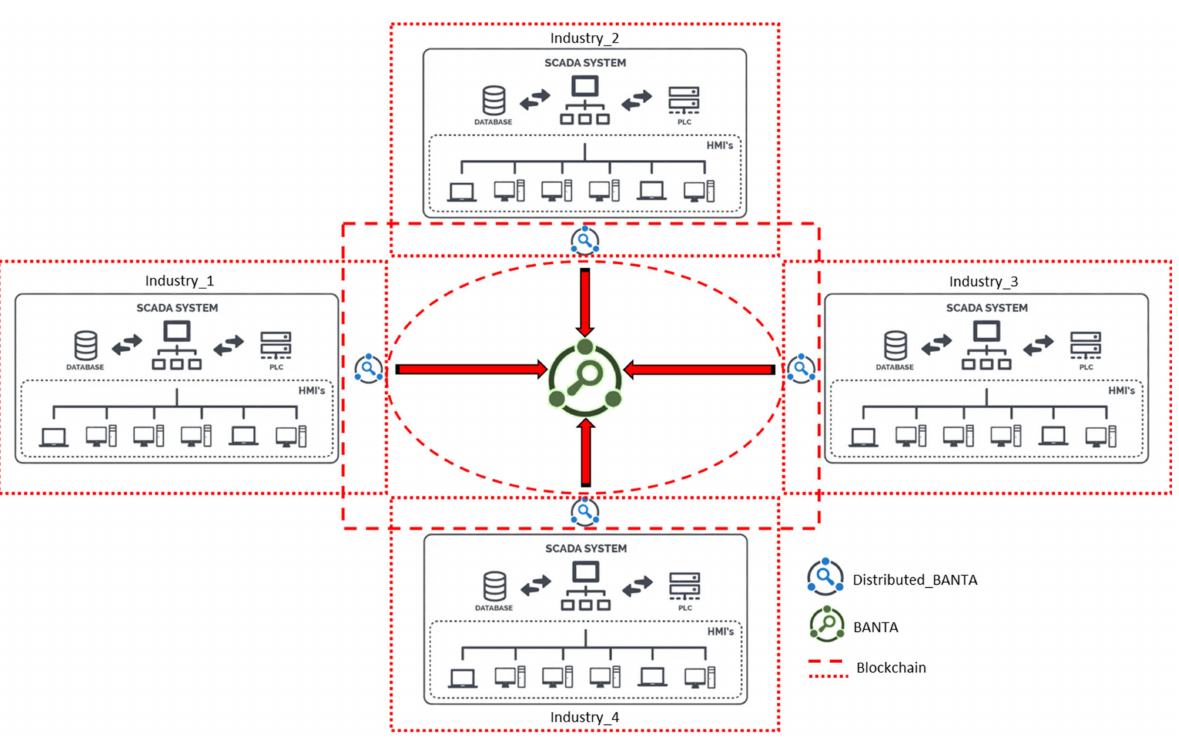
Figure 3. Use case industrial BANTA